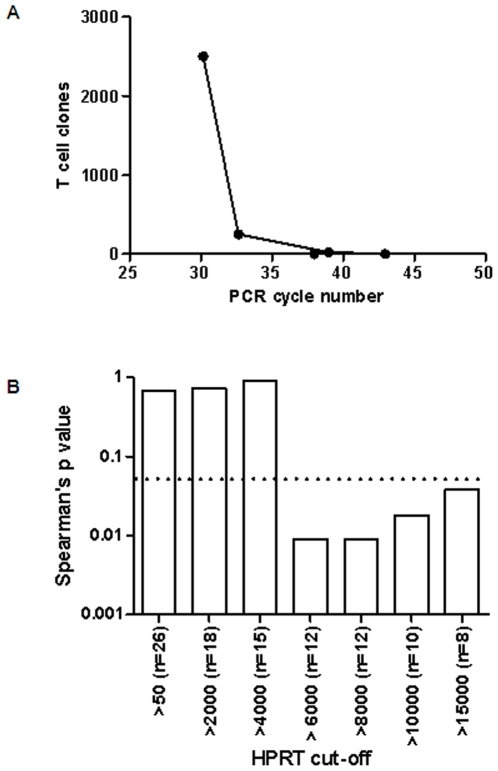
Correlation of qPCR with the IFN-γ ELISPOT assay is dependent on the frequency of antigen specific T cells present and the quantity of viable cells tested.A) The qPCR detection of IFN-γ secreted by a known number's of mouse CD8 T cell clone's. The detection limit is >25 and <250 T cell clones/106 splenocytes. B) Spearman's correlation of TRAP peptide stimulated IFN-γ measured by qPCR and ELISPOT improves as the cut-off for HPRT copy number increases. The dashed line indicates a p value of 0.05.